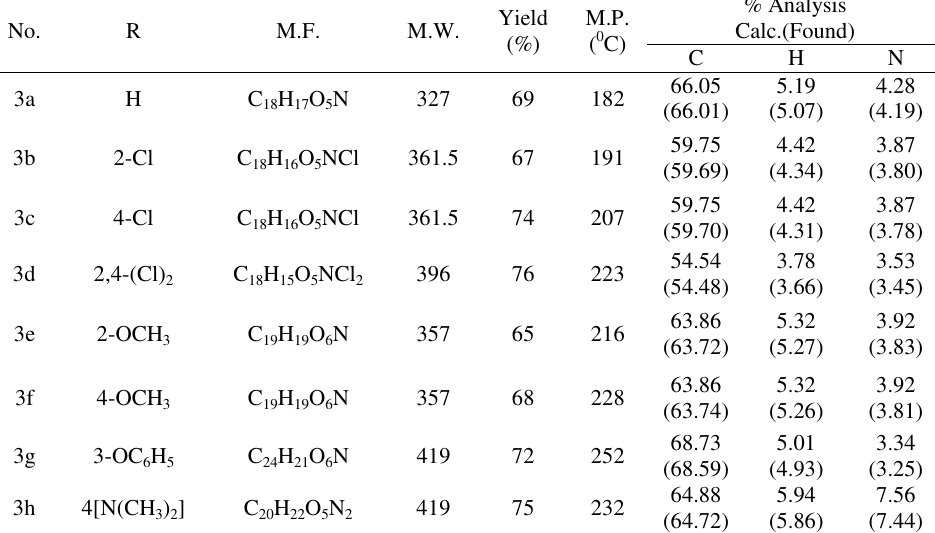
Table-1 Characterization Data of Compounds 3a-3h